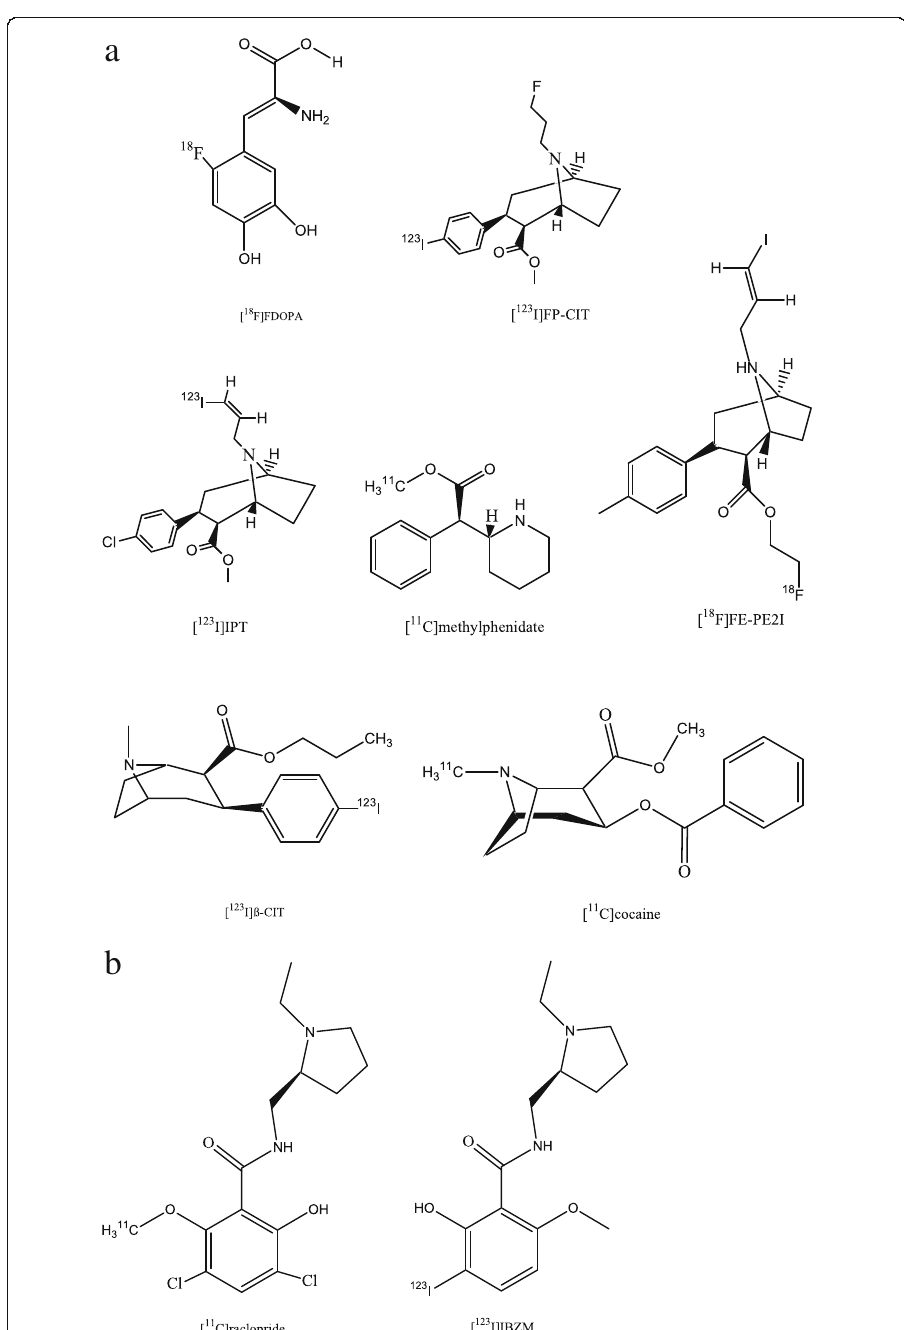
Fig. 4 Chemical structures of radiotracers for imaging the dopaminergic system – targeting: a presynaptic structures and b postsynaptic